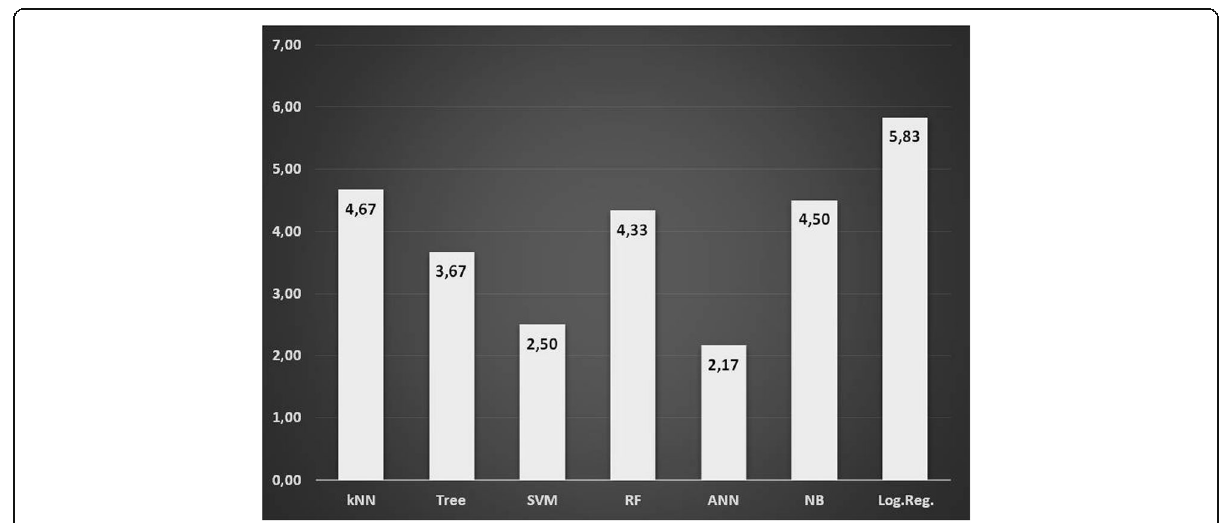
Fig. 3 The mean rank values of the algorithms used for determination of CVS according to classification